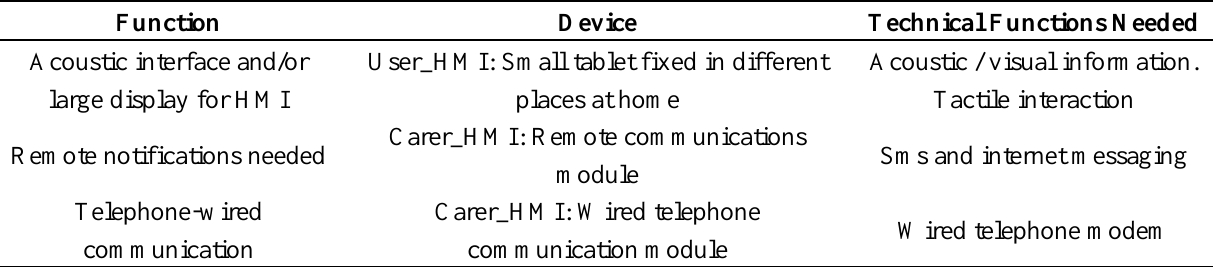
Table 10. Analysis of requirements for Human Machine Interfaces